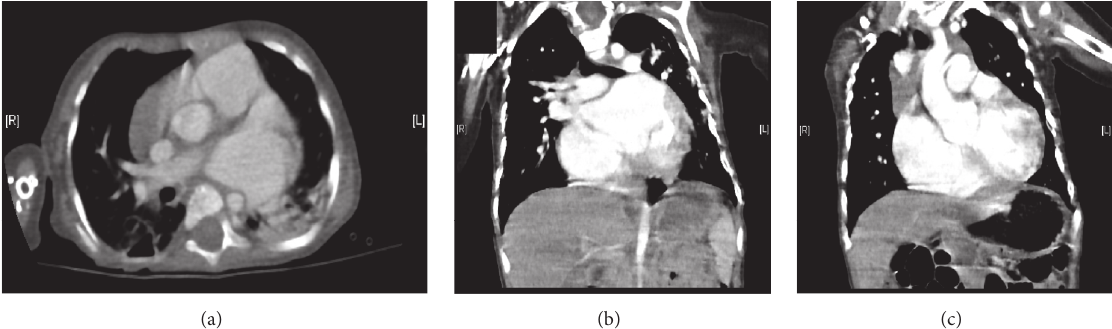
Figure 3: CT scan taken at 7 months: (a) enlarged left atrium and dilated pulmonary trunk. (b) Atrial septal defect. (c) Dilated aortic root and patent ductus